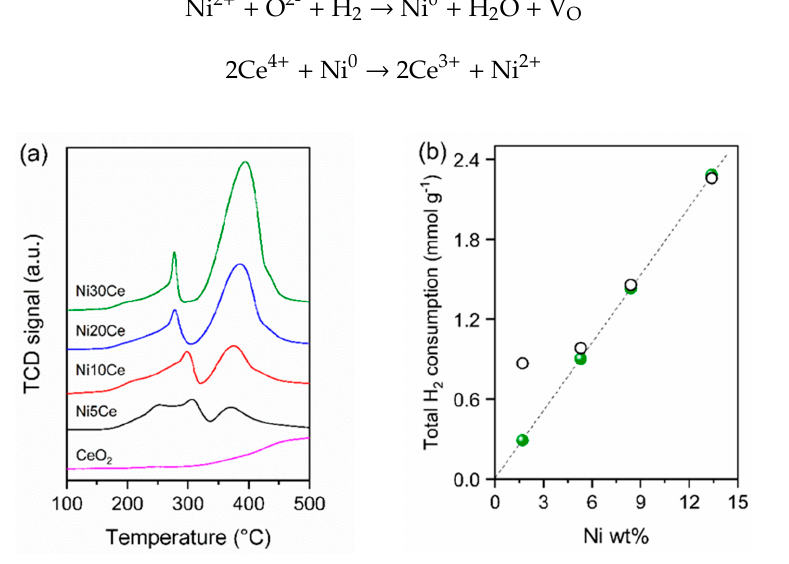
Figure 2. H 2 -temperature-programmed reduction (TPR) analysis: ( a ) profiles of pure r-CeO 2 and NixCe catalysts; ( b ) theoretical ( ● ) and experimental (o) total H 2 consumption as a function of Ni wt%. The Ni wt% of samples are reported in Table 1. Table 2. Cerium reducibility and nickel dispersion .